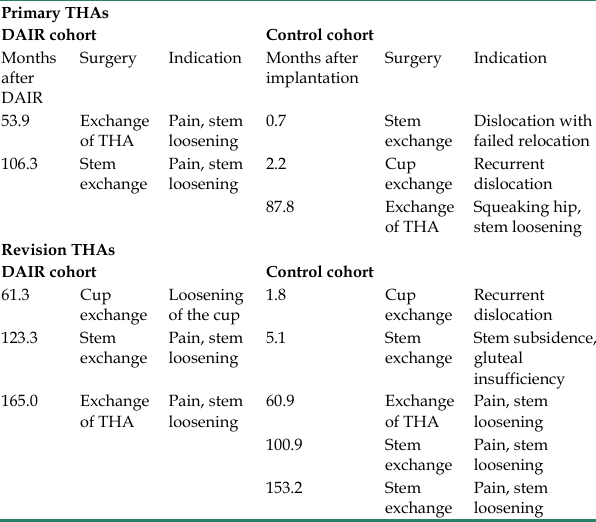
Table 2. Aseptic failures in the DAIR and control cohorts *